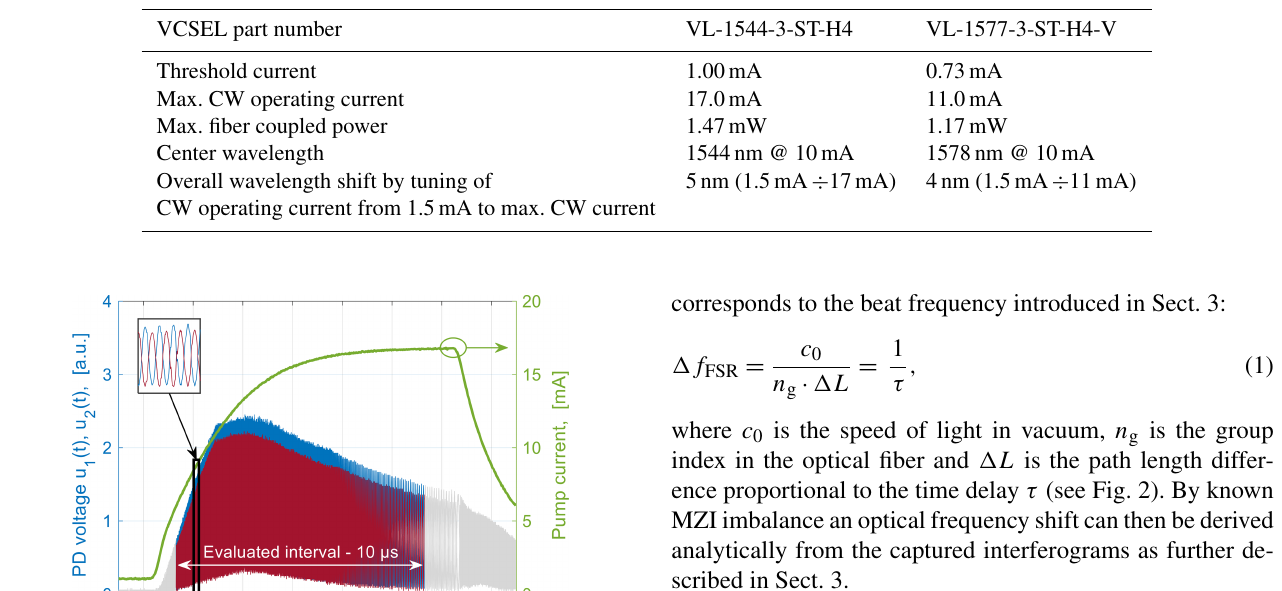
Table 1. Key parameters of the VCSEL at TEC temperature of 20 ◦ C.